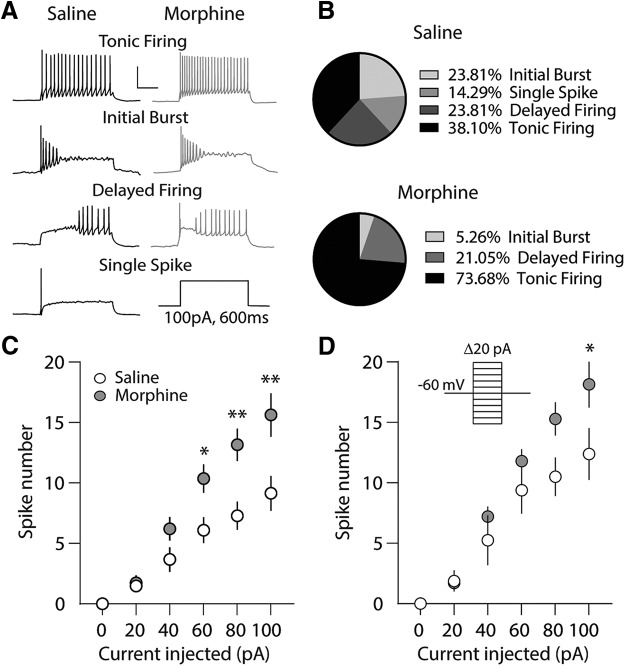
Repeated morphine exposure during the light cycle increases intrinsic membrane excitability of PVT neurons recorded in the light cycle. A, Example traces demonstrating the four firing phenotypes observed in response to a depolarizing current injection (100 pA for 600 ms); tonic firing, initial burst, delayed firing, and single spike (saline, left; morphine, right). Single spike firing patterns were not observed in neurons from animals treated with repeated morphine. Scale bars: 40 mV, 200 ms. B, Quantification of firing phenotypes in PVT neurons following repeated saline or morphine treatment. C, Summary showing that 24 h following repeated morphine injections, the number of action potentials fired in PVT neurons is significantly increased at current injections of 60, 80, and 100 pA (saline: n = 21/5; morphine: 19/6; F(5,190) = 5.14, p = 0.0002; two-way repeated measures ANOVA with Bonferroni post hoc test). D, Summary showing that the number of action potentials fired from PVT neurons expressing tonic firing patterns 24 h after the last saline or morphine injection was significantly different at 100-pA current injection (saline: n = 8/3; morphine: 14/4; F(5,100) = 2.41, p = 0.042; two-way repeated measures ANOVA with Bonferroni post hoc test); *p < 0.05, **p < 0.01.